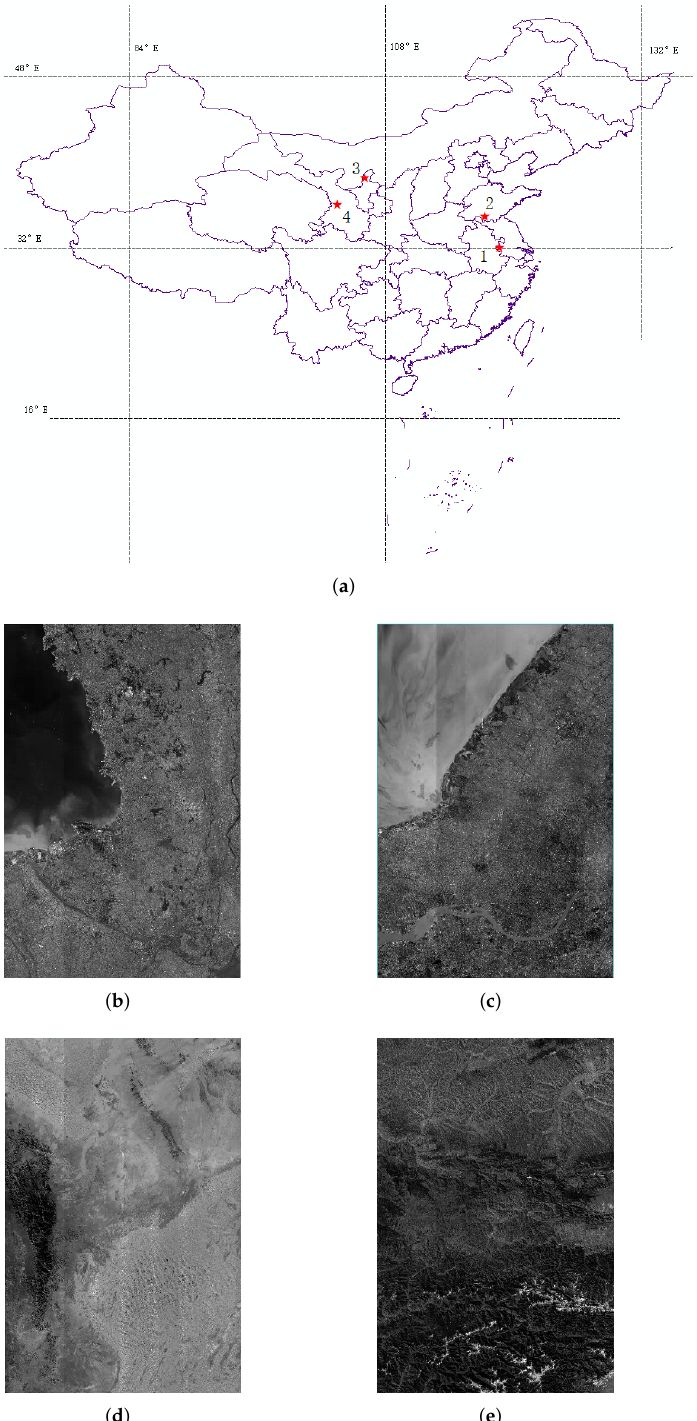
Figure 2. Geometric distribution and overviews of experimented datasets. ( a ) Geometric distribution of the experimental dataset (Nos. 1 ∼ 4 accompanied by red stars indicate the locations of four multi- spectral images, referred to as Image data 1 ∼ Image data 4): ( b ) Image data 1, ( c ) Image data 2, ( d ) Image data 3, ( e ) Image data